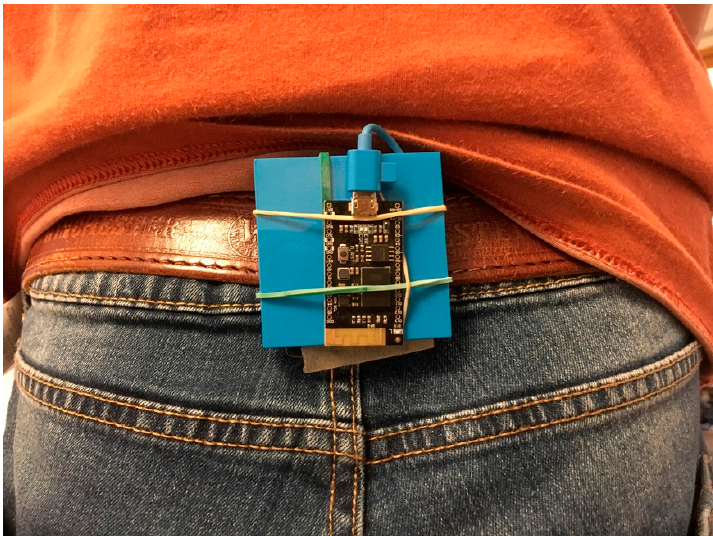
Figure 4. Monitoring device positioned on the belt.